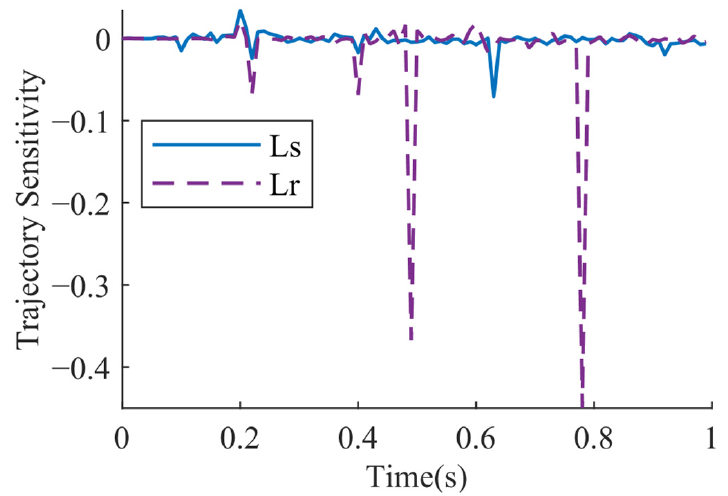
Figure 9. Trajectory sensitivity of s L and r L .